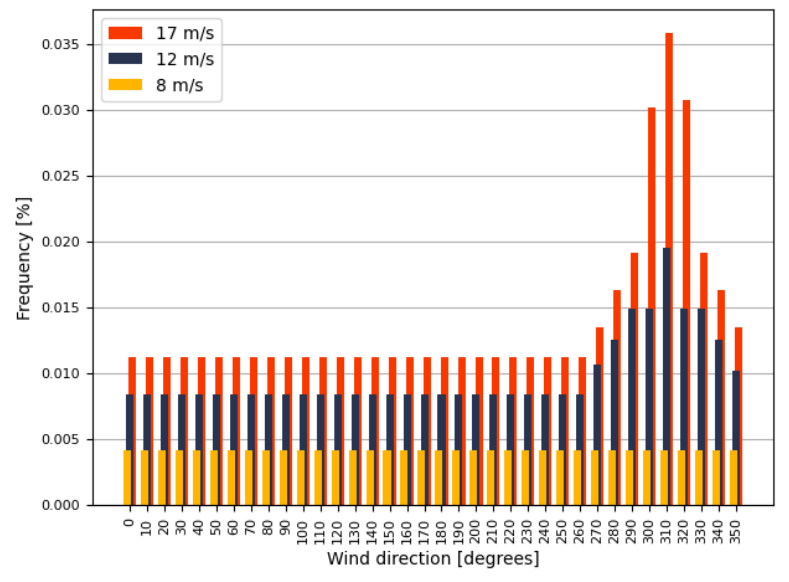
Figure 3. Wind distribution for case 3 (and